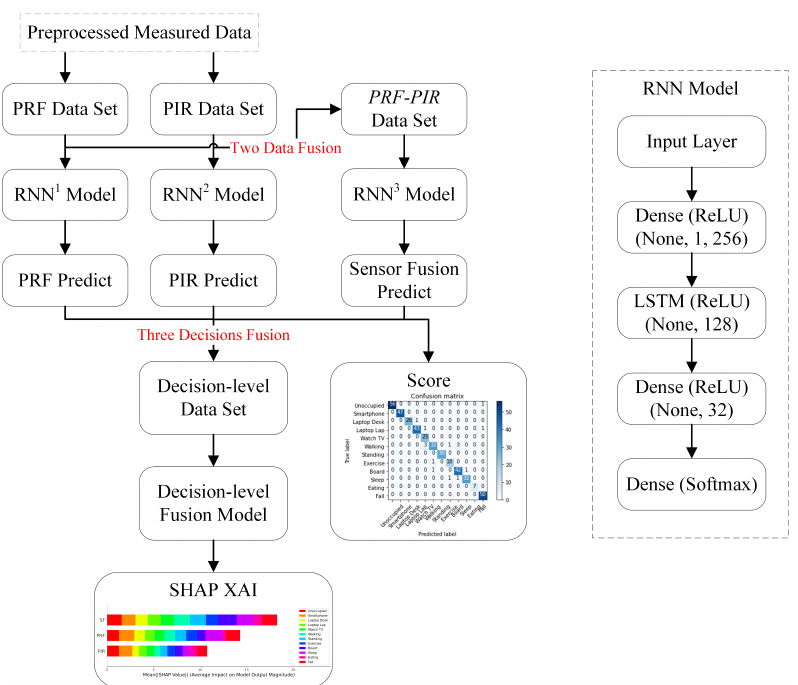
Figure 3. System diagram of PRF-PIR sensor fusion system. RNN 1 , RNN 2 , and RNN 3 use the same model architecture and are used to train different data sets to obtain different models. The PRF-PIR data set is used to train RNN 3 to obtain sensor fusion prediction. Two data fusion and three decisions fusion are marked in the system